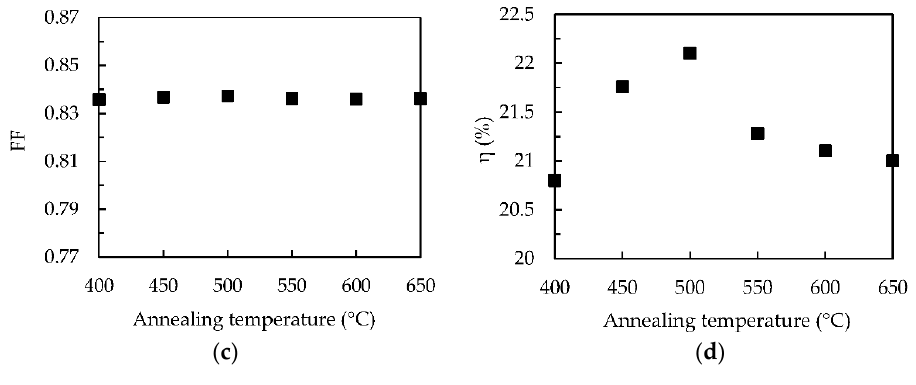
Figure 4. Photovoltaic performance, in terms of ( a ) open-circuit voltage ( V oc ), ( b ) short-circuit current density ( J sc ), ( c ) fill factor ( FF ), and ( d ) conversion efficiency ( η ), of the n-type PERC solar cells as a function of anneling temperature.